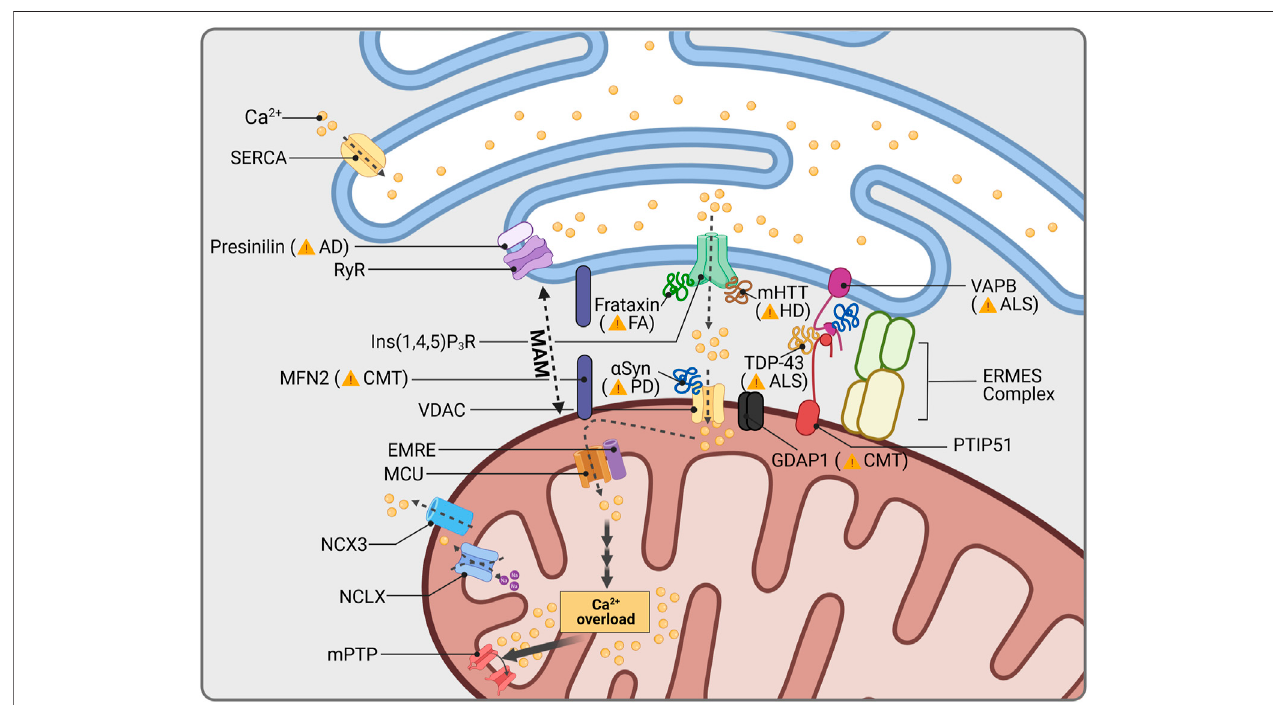
FIGURE3| MitochondrialCa 2+ andneurodegeneration.TheERisthemaincellularorganelletostoreCa 2+ .ERCa 2+ storesarereleasedintothecytoplasmthrough Ryanodine Receptor channels (RyR), whose activity is regulated by the AD-related protein Presenilin. Cellular Ca 2+ homeostasis is centralized in mitochondria- associated membranes (MAMs), the interphase between mitochondria and the ER. MAM structure is stabilized by a group of proteins, among them CMT2A-related MFN2, as well as ALS-linked VAPB and PTIP51. The OMM protein GDAP1 is further present in MAMs and is linked to impaired Ca 2+ signaling, depending on the GDAP1 mutation causing CMT. Other proteins which are associated with human diseases are known to interact with proteins resident in MAMs: Friedreich Ataxia (FA) protein frataxin, stabilizes MAMs through control of ROS levels; aggregates of mHTT increase Ca 2+ release through Ins(1,4,5)P3R; mutations in the ALS-related protein TDP-43 disrupt interaction between VAPB and PTIP51; and PD related α Syn has been found to increase mitochondrial Ca 2+ permeability through VDAC interaction. Mitochondrial Ca 2+ overload induces opening of the mitochondrial permeability transition pore (mPTP), cytochrome c release and apoptosis